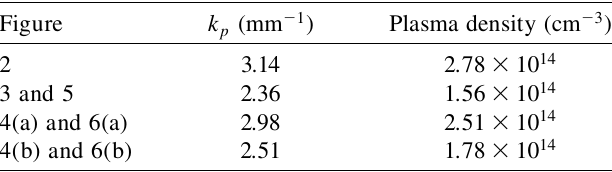
TABLE III. Plasma densities used in figures.